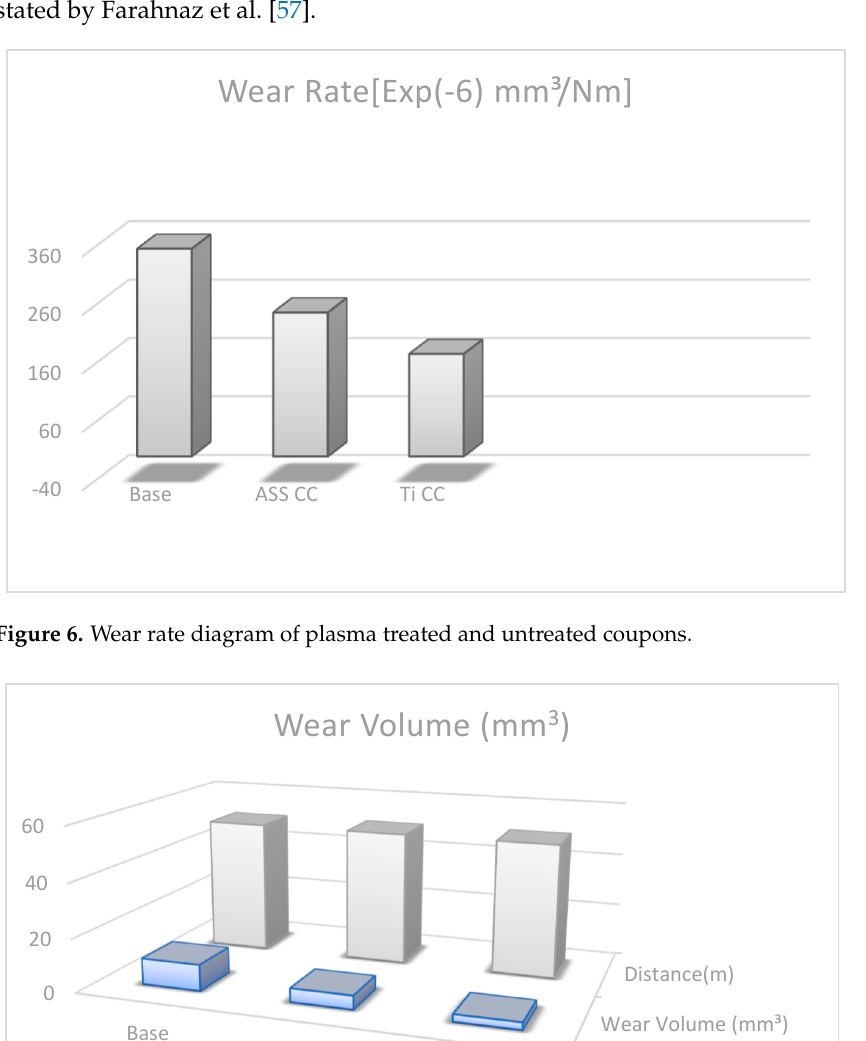
Figure 7. Wear volume pattern of plasma treated and untreated samples.